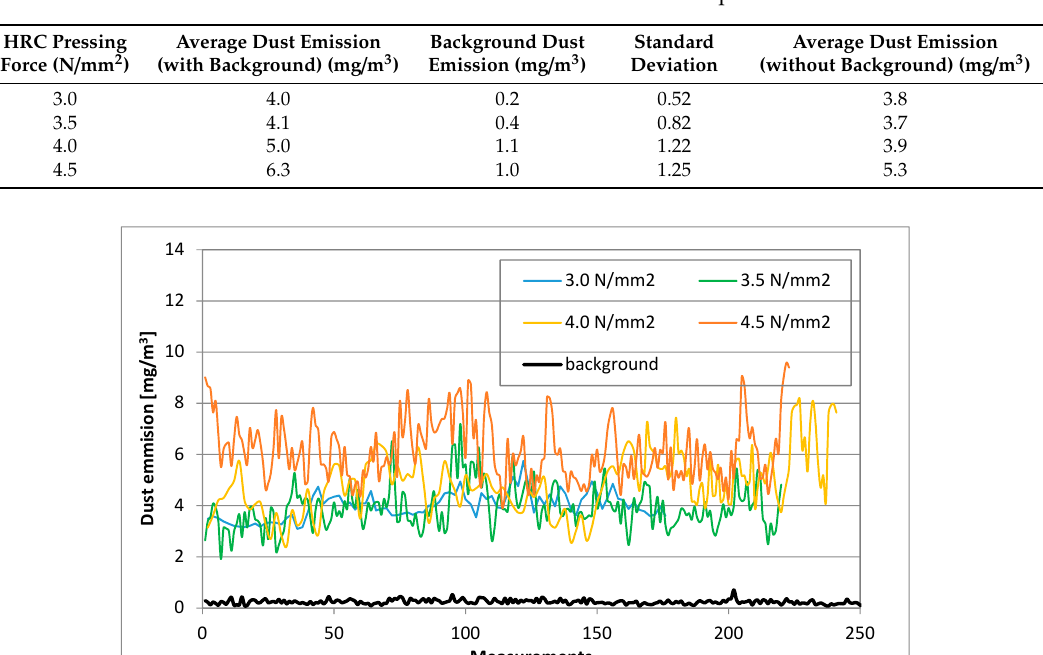
Table 8. Values of dust emissions for the roller press.